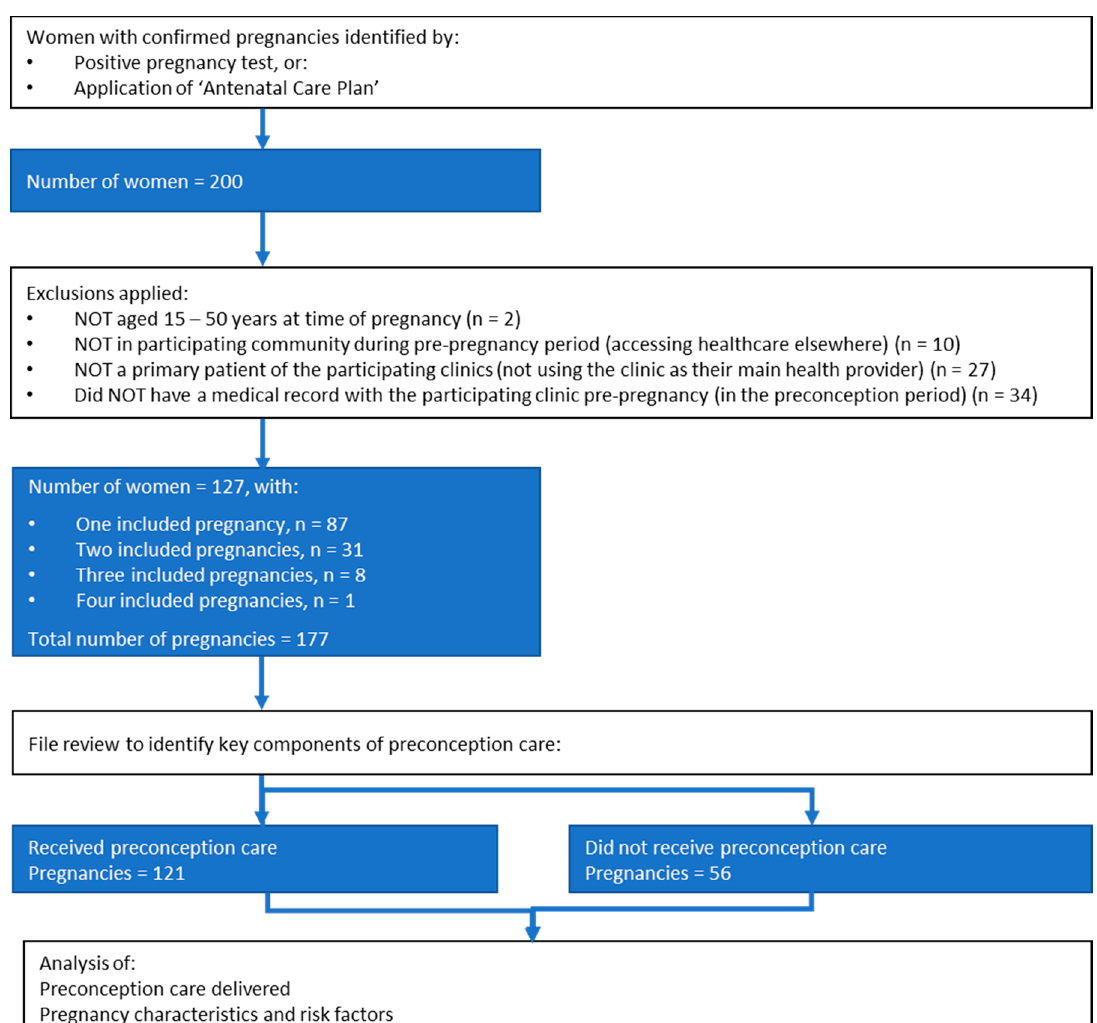
Figure 1. Search strategy applied to identify women with confirmed pregnancies and the preconception care they received (audit period 1 January 2011–1 September 2018).